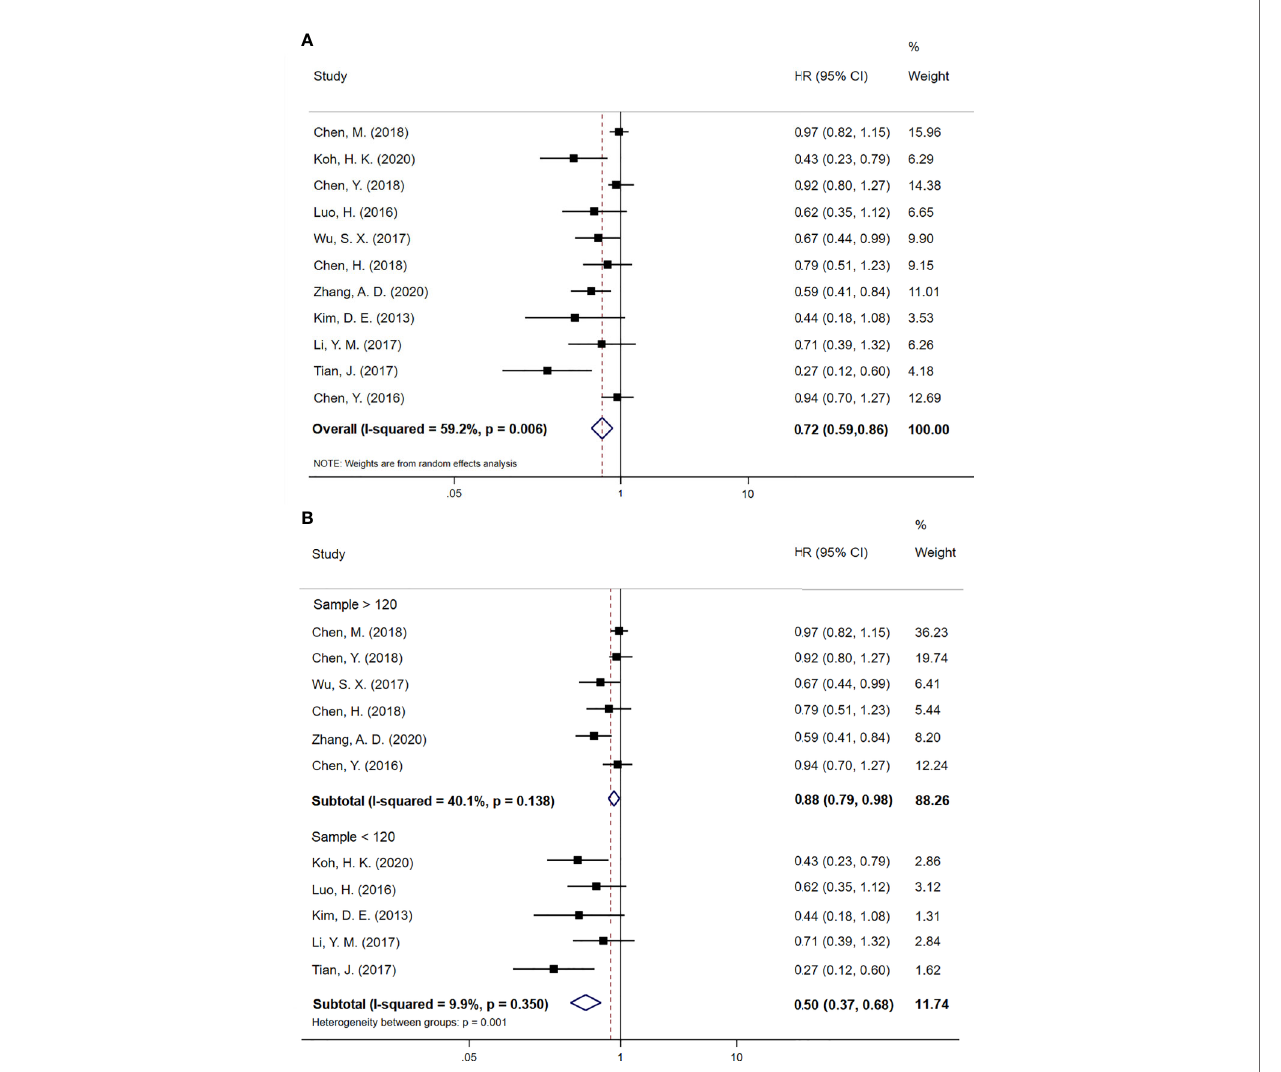
FIGURE 2 | (A) Meta-analysis of the associated HRs of OS for CCRT – CCT compared with CCRT alone. (B) Subgroup analysis of the associated HRs of OS for CCRT – CCT compared with CCRT alone. HR, hazard ratio; OS, overall survival; 95% CI, 95% con fi dence interval; CCRT – CCT, consolidation chemotherapy following concurrent chemoradiotherapy; CCRT alone, only concurrent